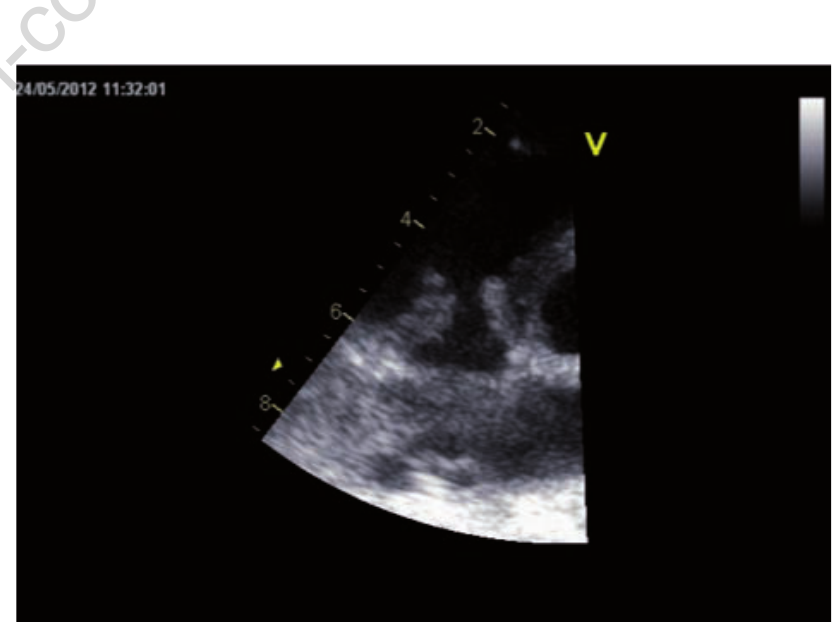
Figure 12. Tricuspid valve involvement in mucopolysaccharidosis type